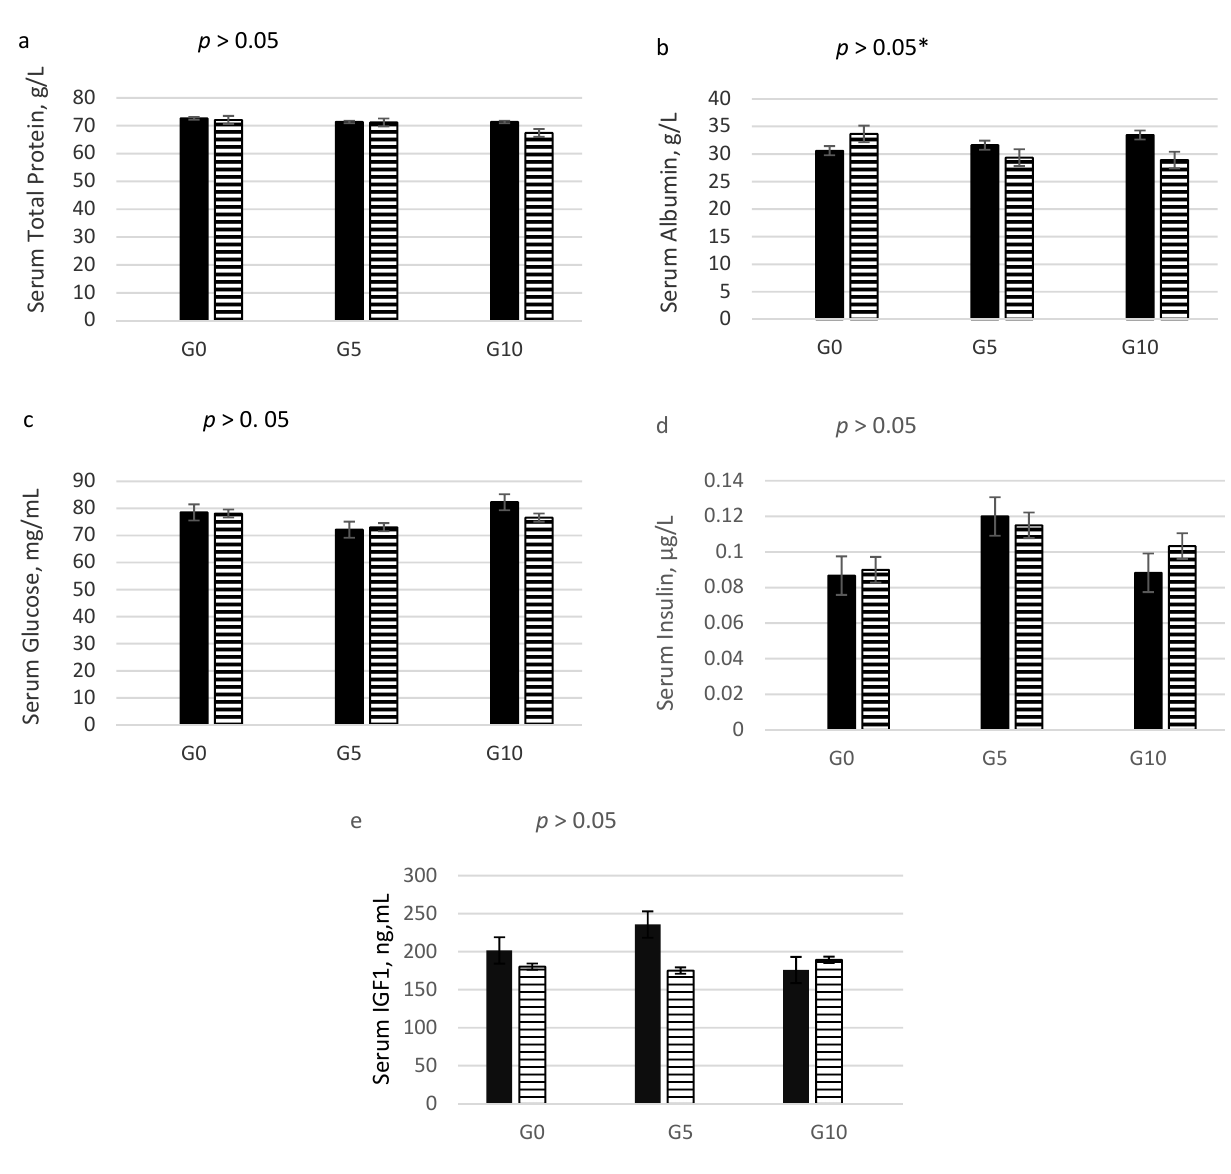
Figure 1. Effects of adding glycerin to feed on serum ( a ) total protein, ( b ) albumin, ( c ) glucose, ( d ) insulin, ( e ) IGF1. G0: diet with 0% crude glycerin. G5: diet with 5% crude glycerin. G10: diet with 10% crude glycerin. Data show least squared means ± standard error. n = 16 animals per dietary treatments. * p > 0.05, except for albumin diet × sex p -value = 0.036.